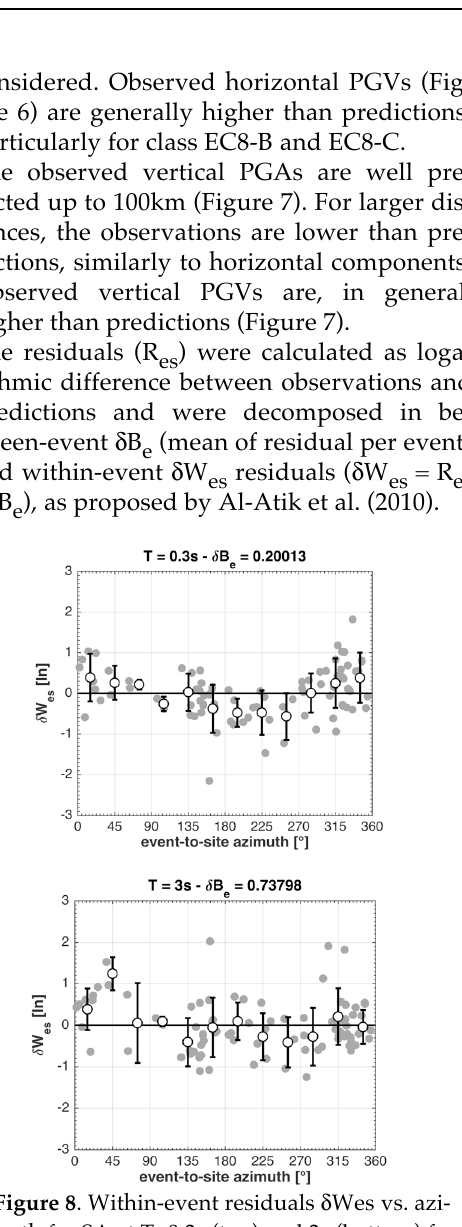
Figure 9 . Velocity time history (a) and power spectrum (b) of the E component at station